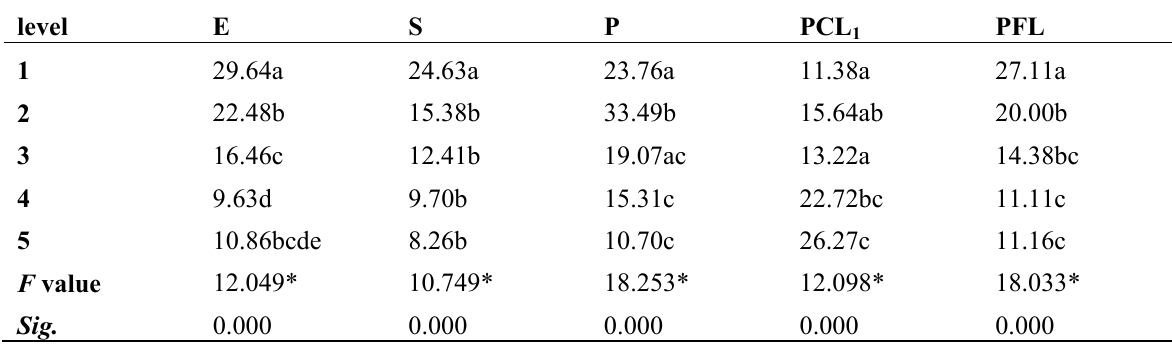
Table 10. Effect of different environment factors on soil available phosphorus in subwatershed scale